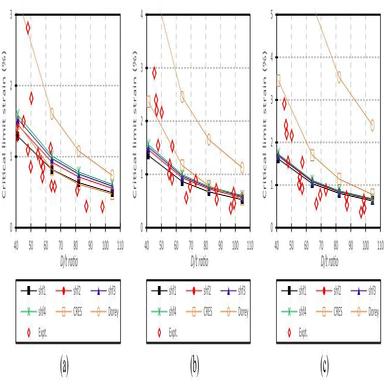
Comparison of CLS models with experimental test results for RHT X70 pipe. (a) fp = 0.0, (b) fp = 0.4, and (c) fp = 0.8.